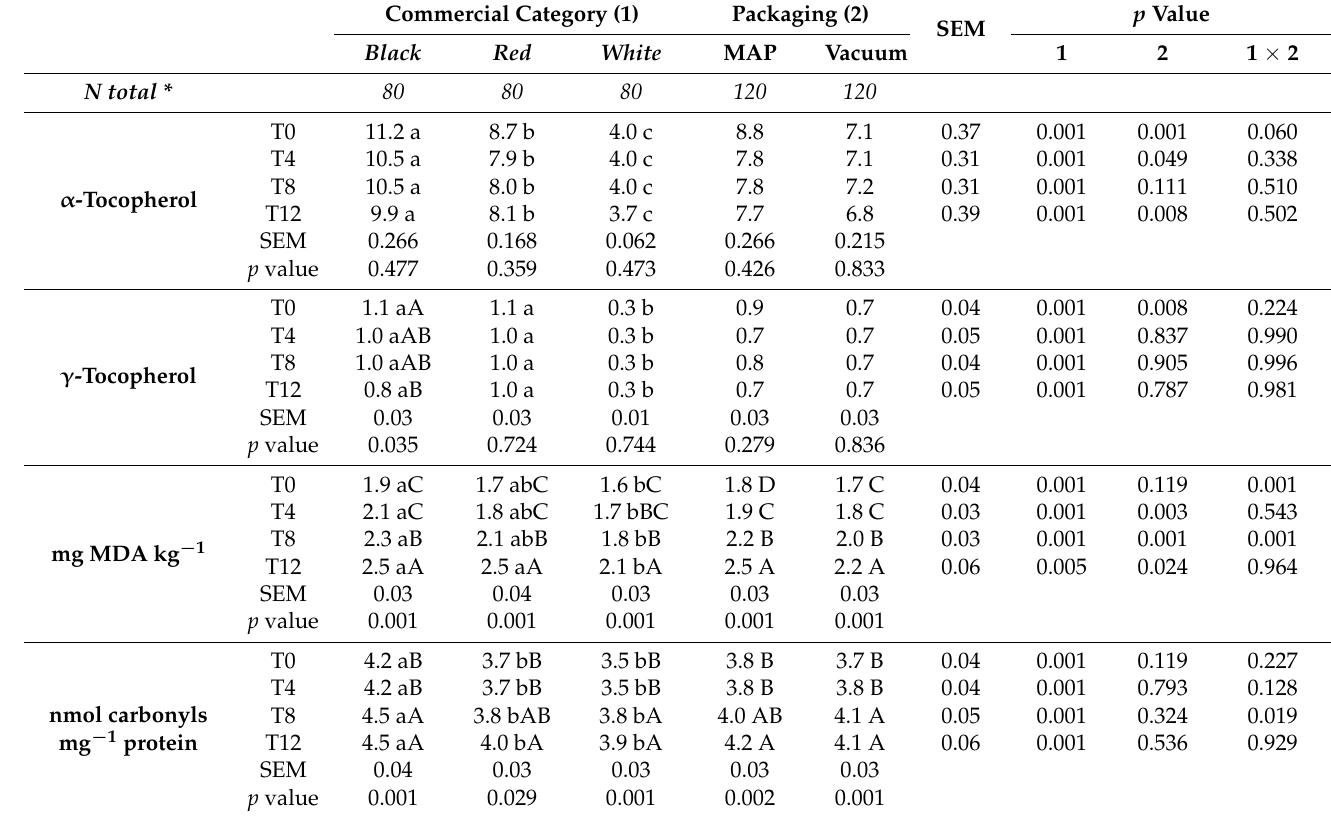
and the diet. α -tocopherol content was significantly higher at all sampling times (T0–T12) in slices from the Black category than from the White one, while the Red category showed intermediate levels. Regarding packaging, MAP showed higher levels of α -tocopherol at T0, T4 and T12. γ -Tocopherol was significantly higher in slices from the Black and Red categories than those from the White one at all times of storage (T0–T12). However, levels were importantly reduced during storage in slices from the Black category. In addition, at T0, γ -tocopherol content was higher in MAP than in vacuum packages. Table 3. Tocopherol content ( µ g g − 1 ) and lipid (TBARS values) and protein oxidation changes of sliced Iberian dry-cured ham from different commercial categories and with different packaging conditions for 12 months of refrigeration